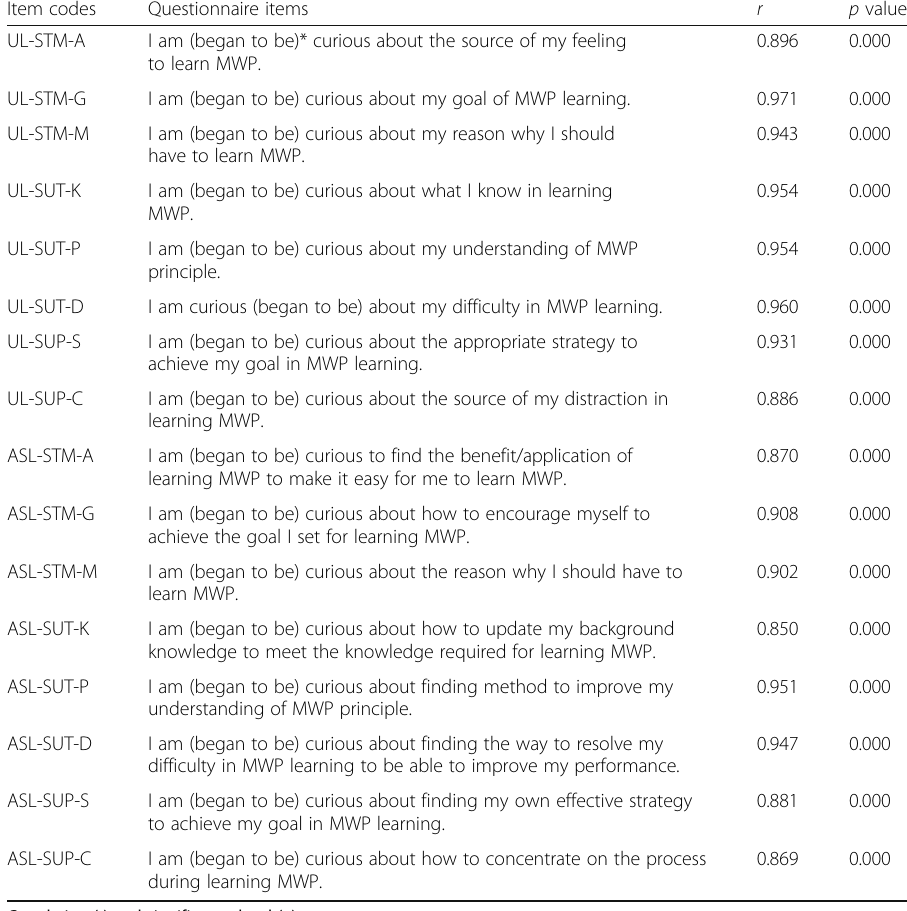
Table 3 Items of the Q-L2SRL and their Pearson ’ s correlation values from the test-retest reliability Item